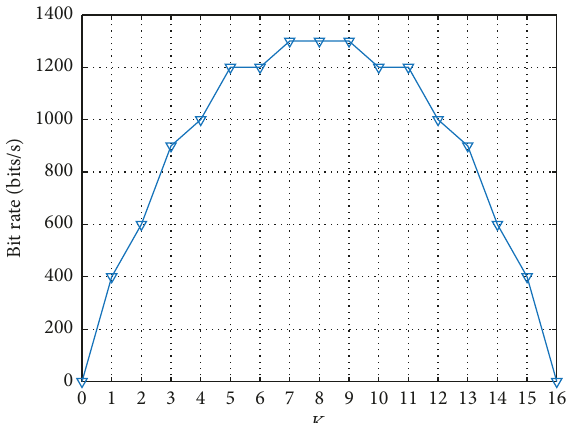
Figure 7: Bit rate of the proposed scheme for various K with N